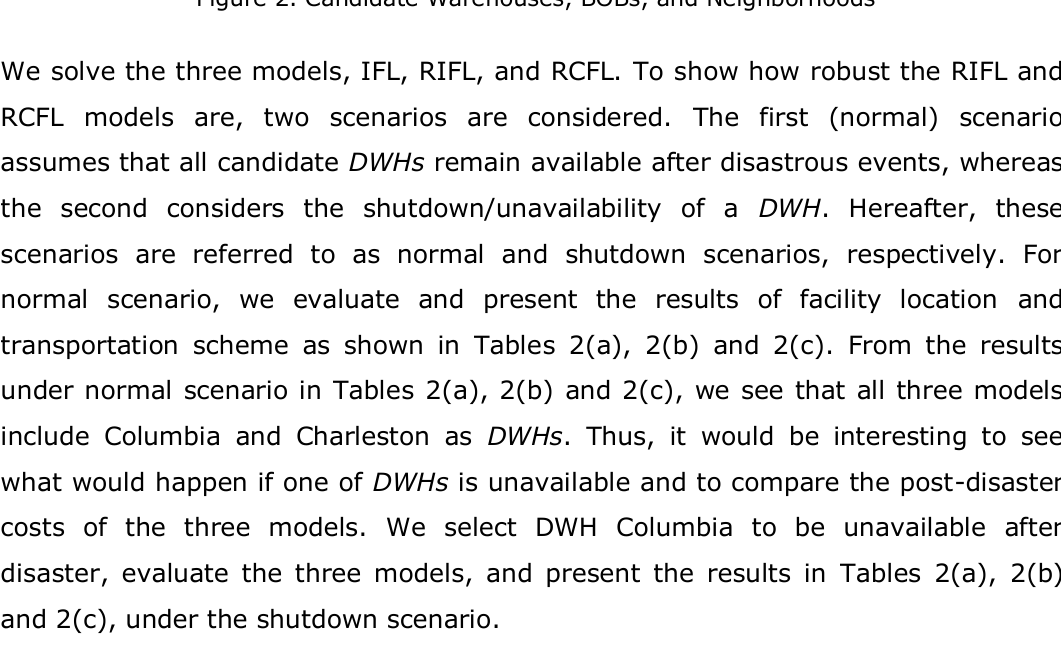
Figure 2. Candidate Warehouses, BOBs, and